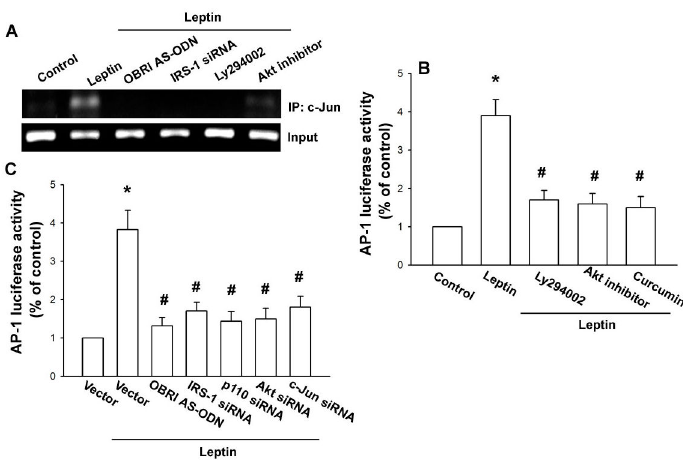
Figure 6. Leptin induces AP-1 activation through OBRl receptor/IRS-1/PI3K/Akt pathway. (A) OASFs were pretreated with Ly294002 and Akt inhibitor for 30 min or transfected with OBRl AS-ODN and IRS-1 siRNA for 24 h and then stimulated with leptin for 120 min, and chromatin immunoprecipitation assay was performed. Chromatin was immunoprecipitated with anti-c-Jun. One percent of the precipitated chromatin was assayed to verify equal loading (input) (n=4). (B and C) OASFs were transfected with AP-1-luciferase expression vector and then pretreated with Ly294002, Akt inhibitor, and curcumin or cotransfected with OBRl AS- ODN, IRS-1 siRNA, p110 siRNA, Akt siRNA, and c-Jun siRNA before incubation with leptin for 24 h. Luciferase activity was then assayed. Results are expressed as mean ±S.E.M. of four independent experiments. *: p < 0.05 as compared with basal level. #: p